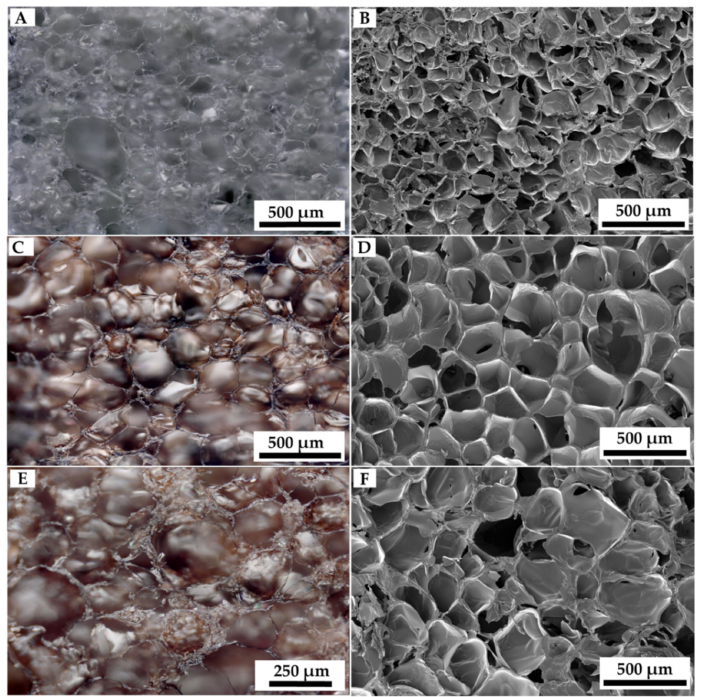
Figure 6. Optical microscopy ( left ) and SEM images ( right ) of some representative G 10 C z N 10 gels as a function of the added catechol concentration. With ( A , B ) G 10 N 10 , ( C , D ) G 10 C 20 N 10 , ( E , F ) G 10 C 60 N 10